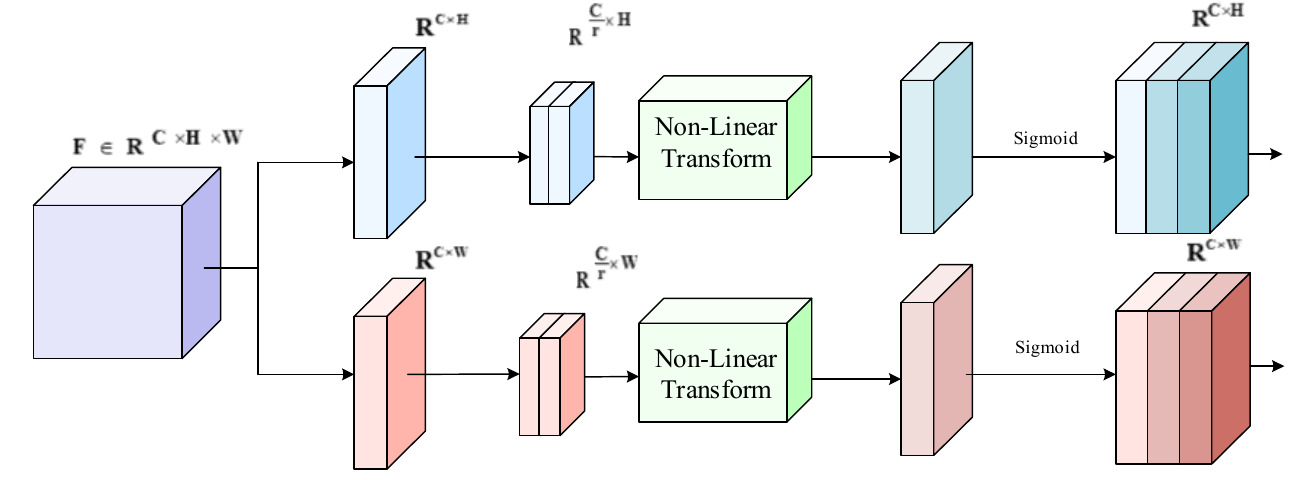
Figure 6. Position attention module structure diagram.